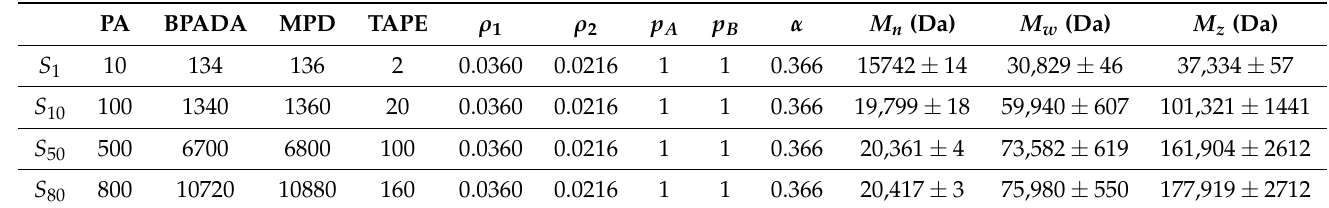
Table 3. Four fully reacted, stoichiometric systems that are all below the gel point, but with the size increased proportionally without changing the molar ratio of monomers. The entries have the same format as in Table 2. The subscript of the system label in the first column indicates the size ratio with respect to the base system, S 1 . The average molecular weights, M n , M w , and M z , are from the MC